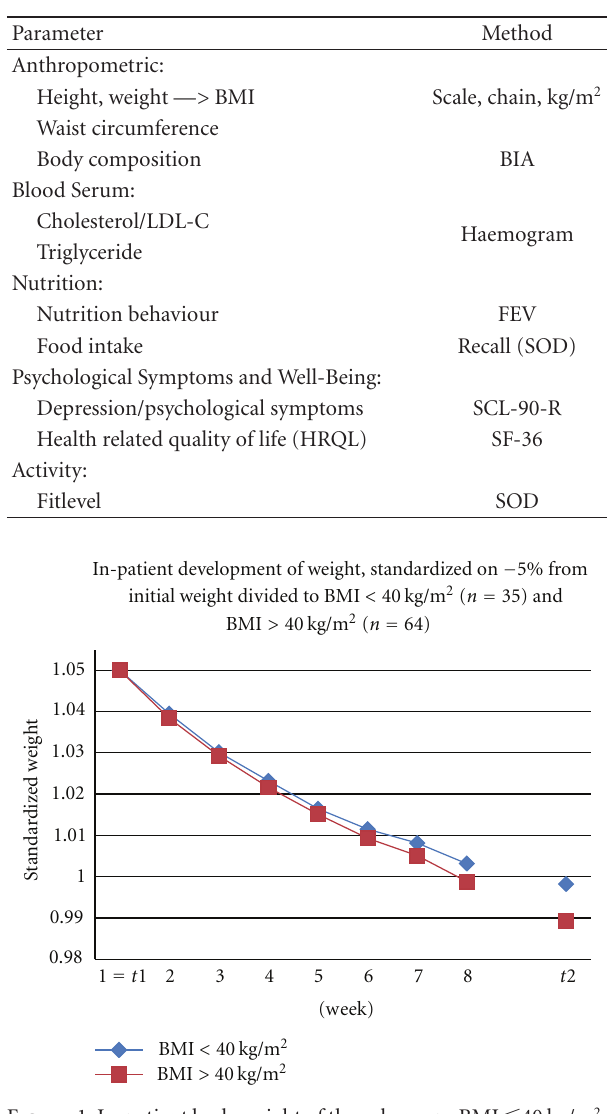
P = 0 . 001). Model-based classifications (cut-o ff of